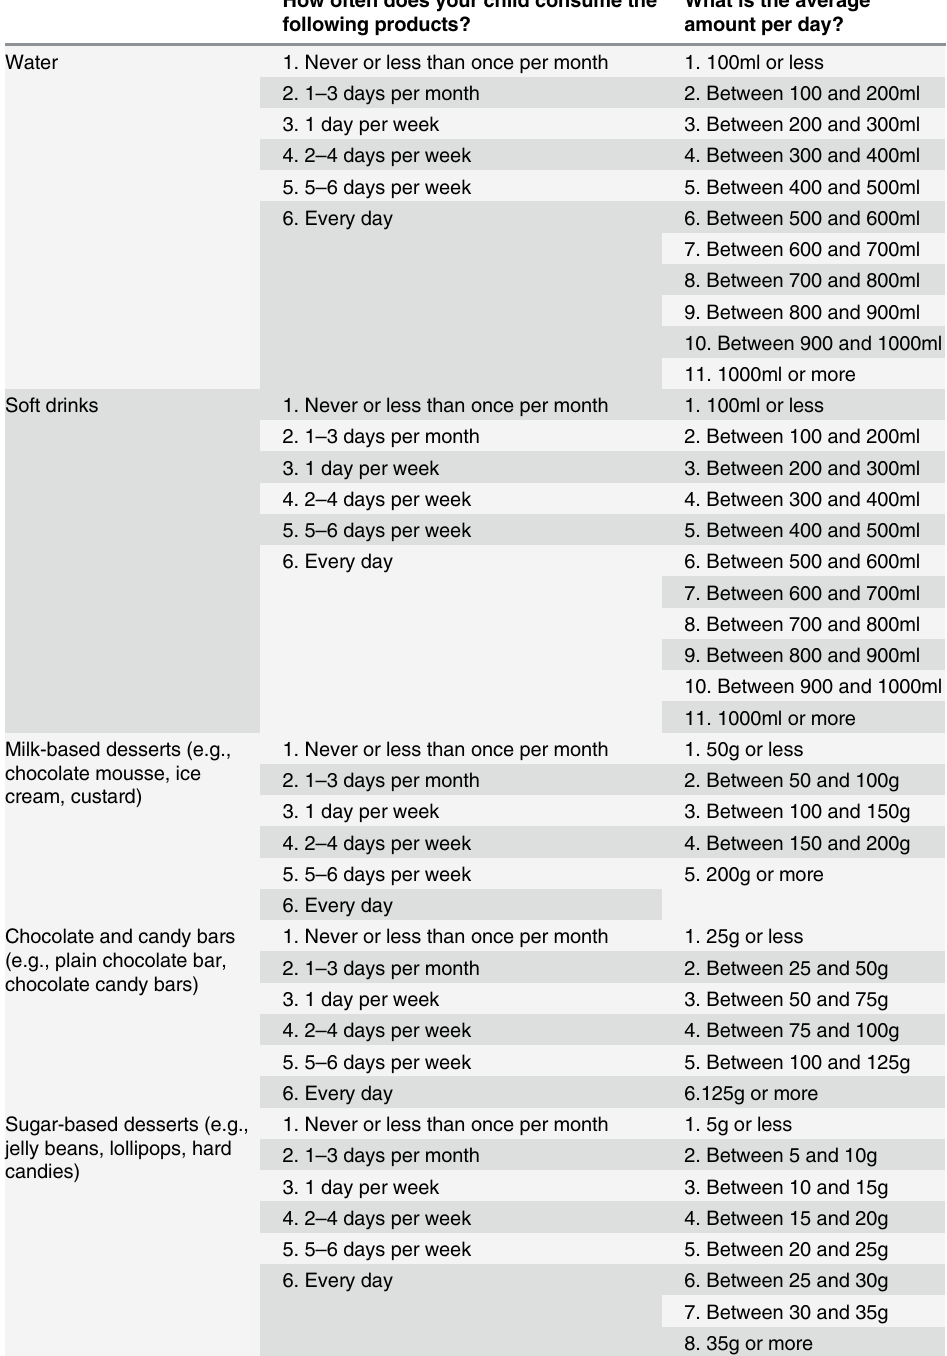
Table 2. Questions and answer possibilities on preschoolers ’ water, sugar-sweetened beverage and snack